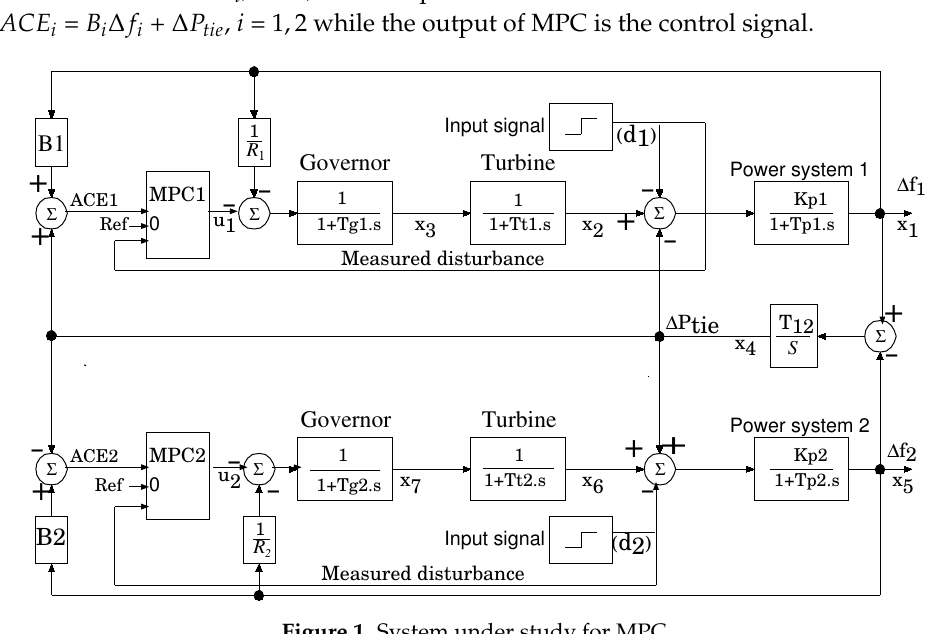
Figure 1. System under study for